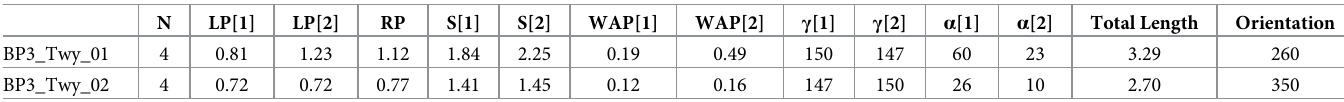
Table 5. BP3 trackway